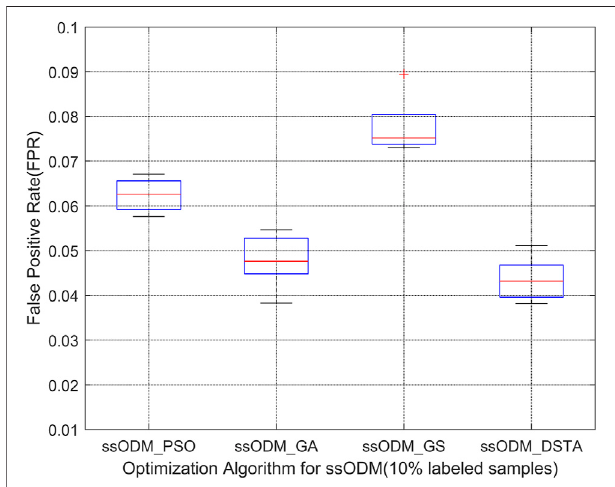
FIGURE 5 | Boxplot of FPR of fault detection regarding the pitch emergency stop (10% labeled samples).